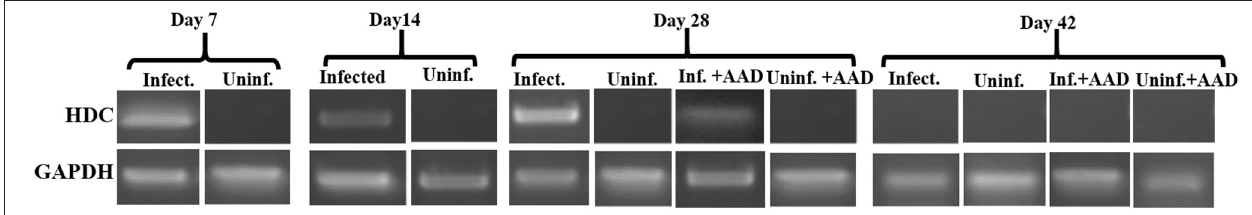
FIGURE 9 | HDC mRNA expression in BAL neutrophils. Analysis of purified BAL neutrophils for the mRNA expression of HDC confirmed only infected animals expressed HDC from days 7 to 28. HDC was not present in BAL neutrophils recovered from the airways of AAD only or uninfected groups. HDC expression ceased in these cells after bacterial clearance.